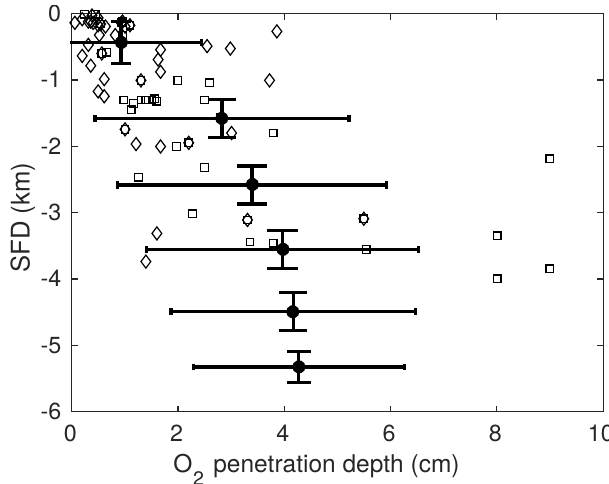
Figure 15. Sea-floor depth versus O 2 penetration depth for the depth-dependent parameterisation after Boudreau (1997) with k 1 = x( SFD ) · k 2 . Diamonds represent observations compiled by Meile and Van Cappellen (2003) and squares observations from Glud (2008). Circles are the mean model results for the six SFD bin classes (with standard deviations). Grid cells in which the entire sediment column is oxic (i.e. z ox = 100cm) are not considered in these statistics (17, 32, 102, 300, 477 and 307 cells for the six bin classes,